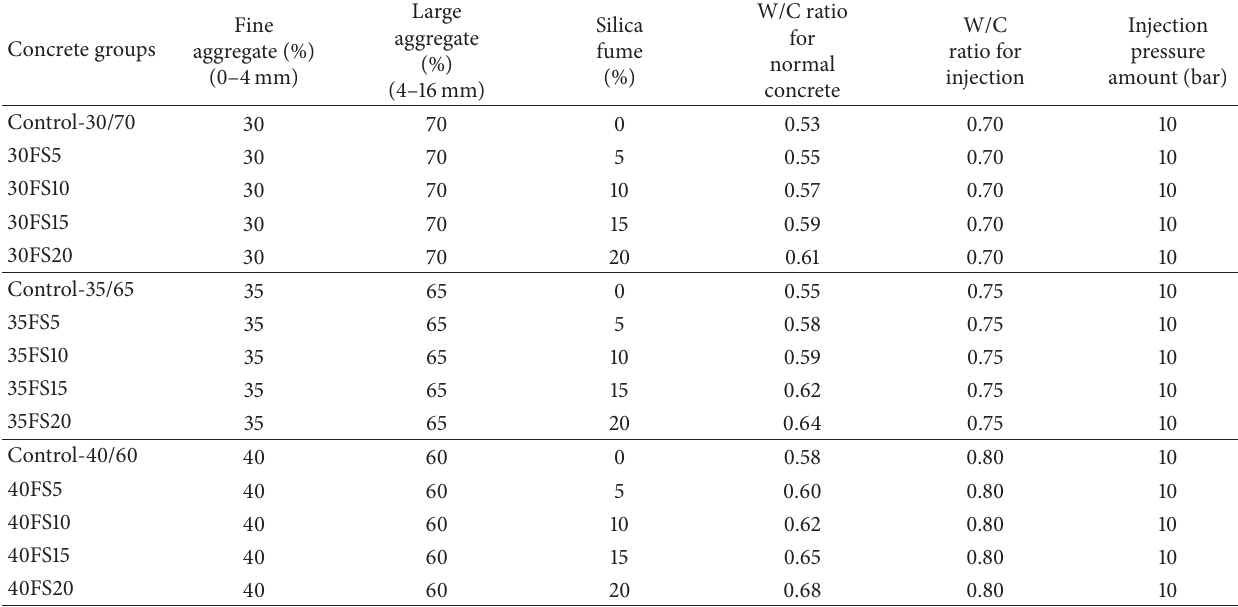
Table 2: Basic properties of cement mixtures.